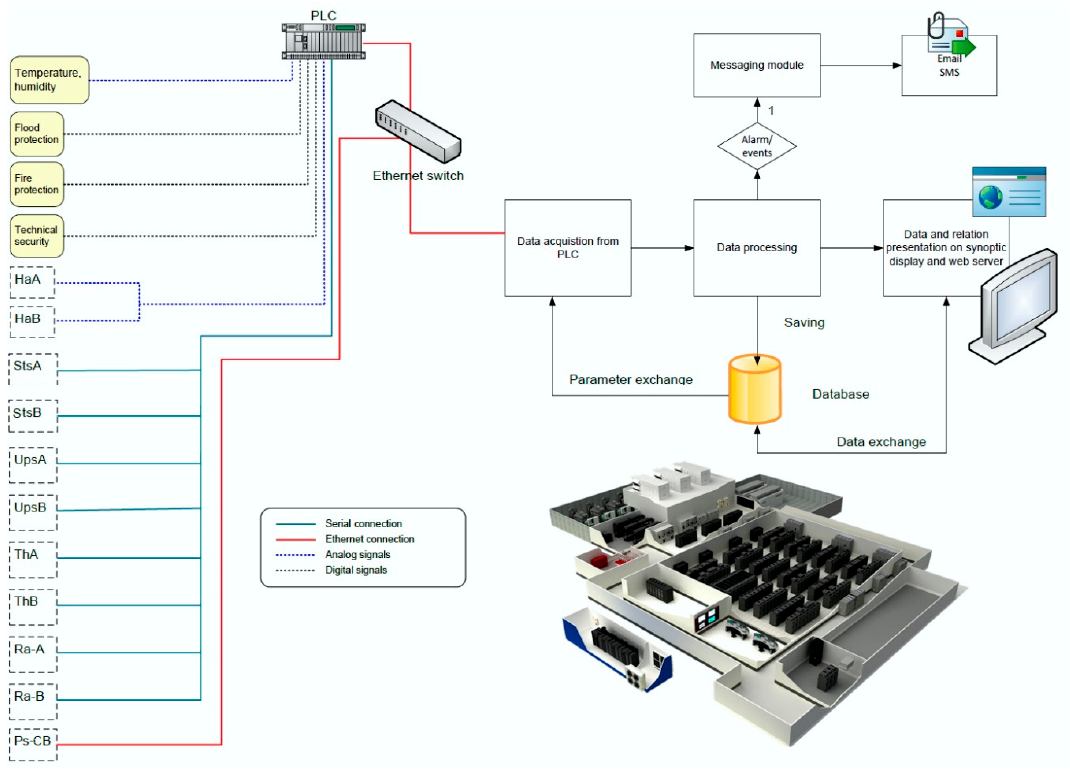
Figure 1. Data center infrastructure.